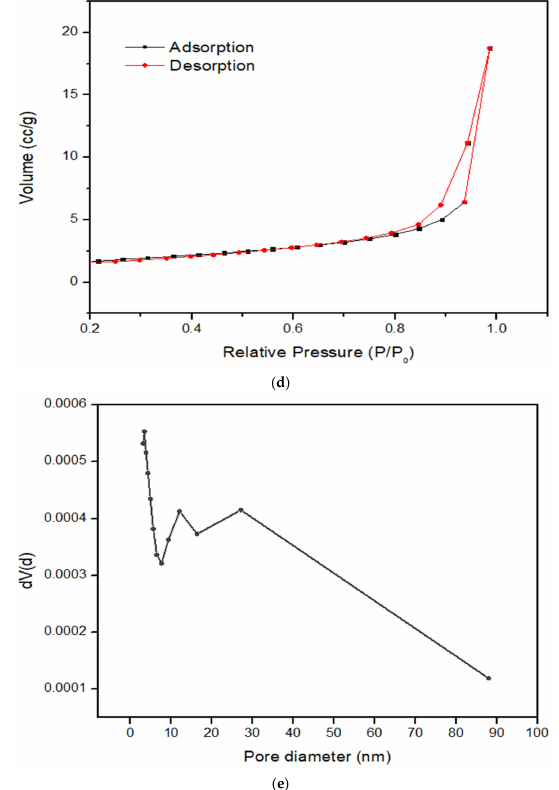
Figure 2. ( a ) Determination of the size of gold nanoparticles via the DLS technique. ( b ) Surface characterization of synthesized MIP with CagA template. ( c ) Surface characterization of synthesized MIP after removal of the CagA template. ( d ) BET isotherm; adsorption and desorption curve. ( e ) Analysis of pore size distribution for MIP by BET. 3.2. Geometry Optimizations Computational simulation has been e ff ectively used to elucidate the nano − bio inter- action in biosensor platforms [51,52]. In this study, the polymerization process of MIP was optimized through molecular modelling in order to determine the energetic contributions towards the binding event of the MIP template. To realistically simulate the MIP compo- nent, the overall molecular structures of MIP were constructed and energetically opti- mized. In the first step, the electrostatic potential (ESPs) and the highest occupied